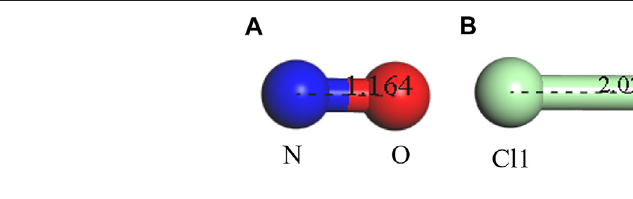
FIGURE 1 | Structures of (A) NO, (B) Cl 2 , and (C) O 3 .